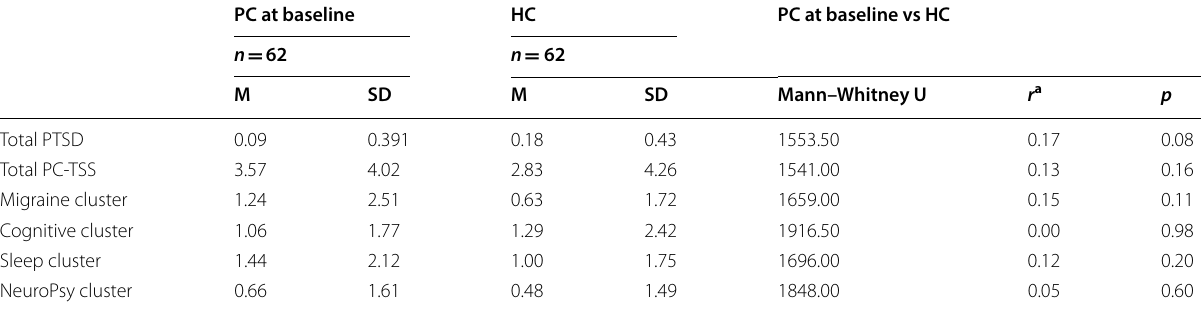
Table 7 ImPACT total symptom score cluster descriptive statistics, Mann–Whitney U-tests, effect sizes (d) and significance levels (p) N =